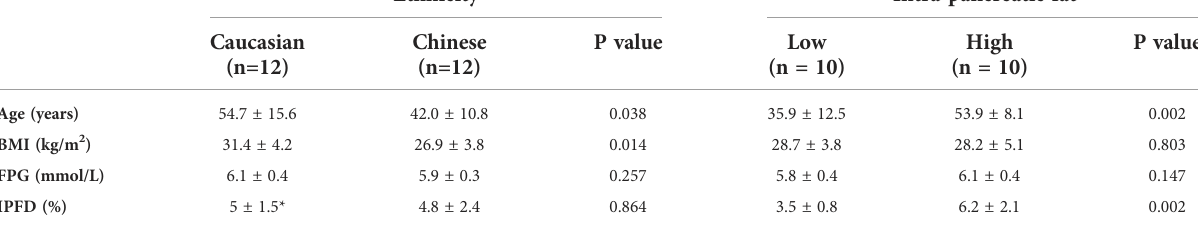
TABLE 1 Participant characteristics.